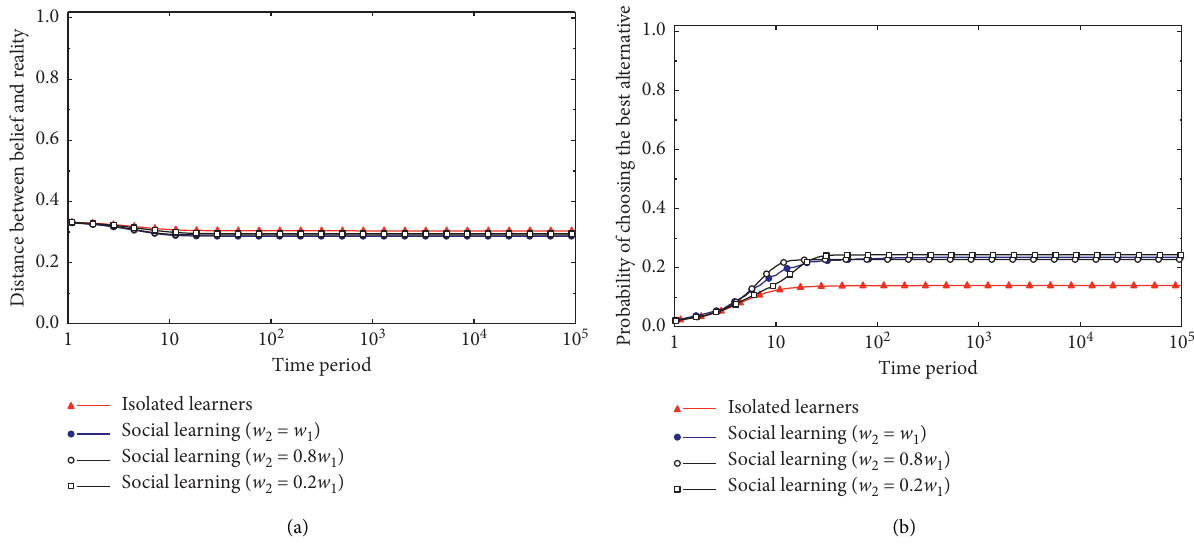
Figure 8: (a) Degree of biased beliefs (i.e., the distance between belief and reality); (b) probability of choosing the optimal alternative ( w represents weight on information from the other, while w